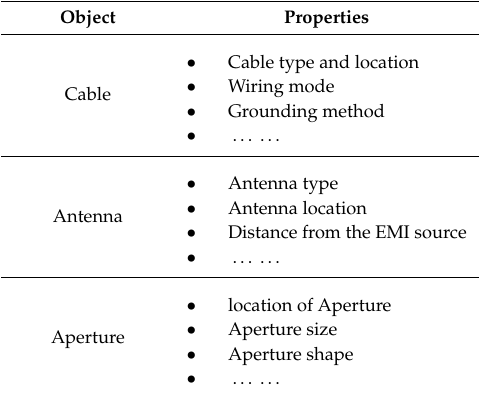
Table 2. Objects and their properties.